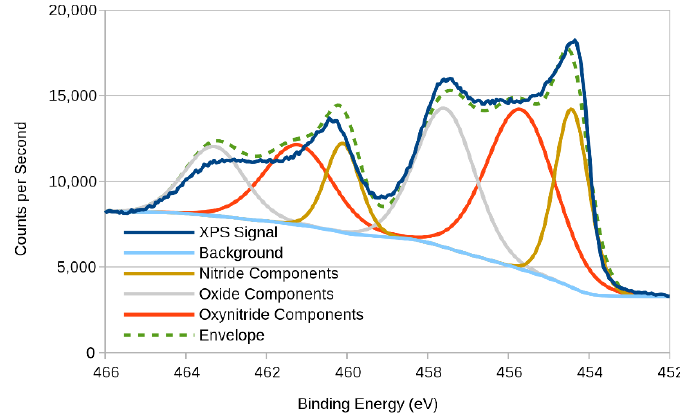
Figure 11. XPS results and component fitting for Ti 2p region of titanium nitride.